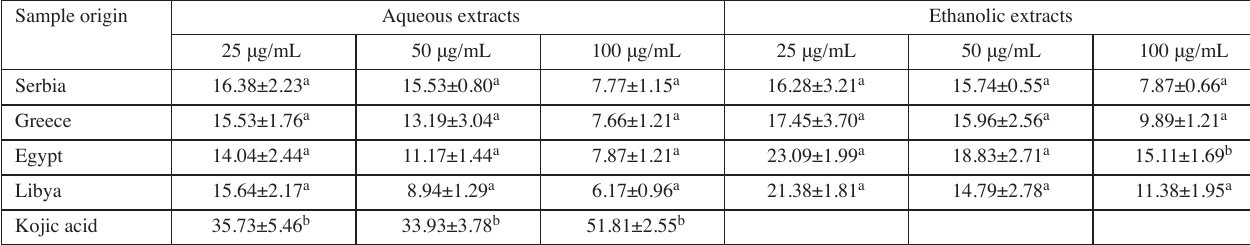
Tab. 7: Tyrosinase inhibitory activity of O. majorana extracts and kojic acid (standard) presented as percentage of tyrosinase inhibition (%) Sample